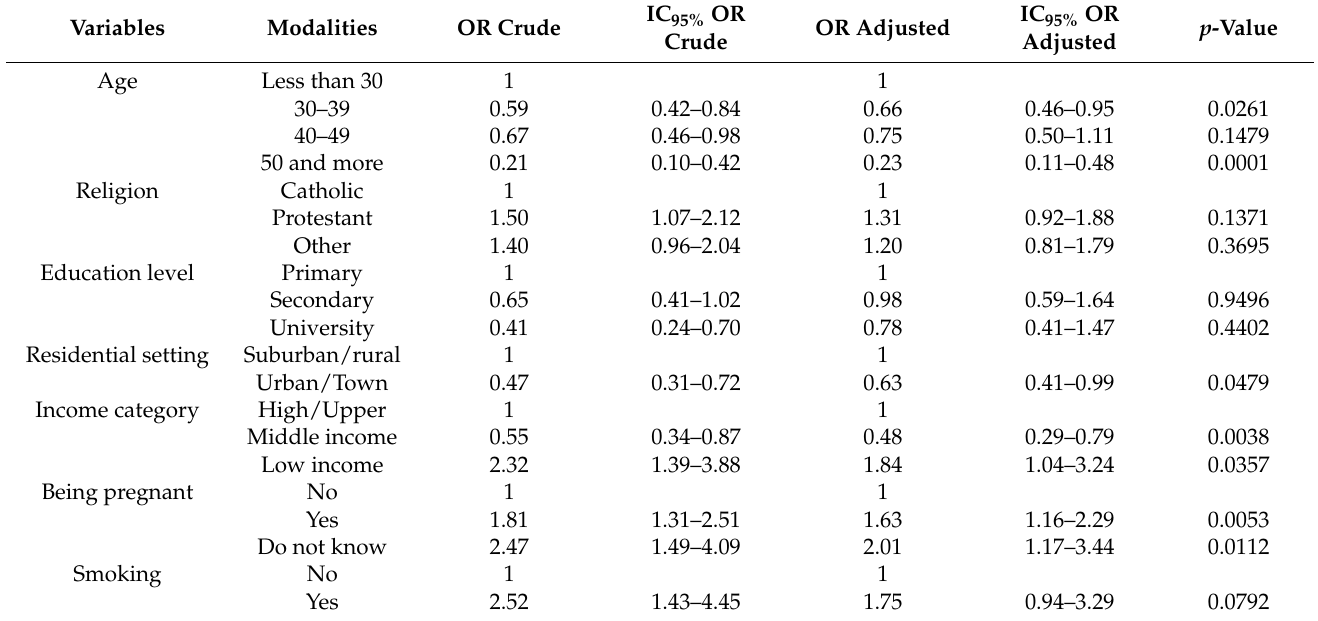
Table 4. Factors associated with Intimate Partners’ Violence ( n =